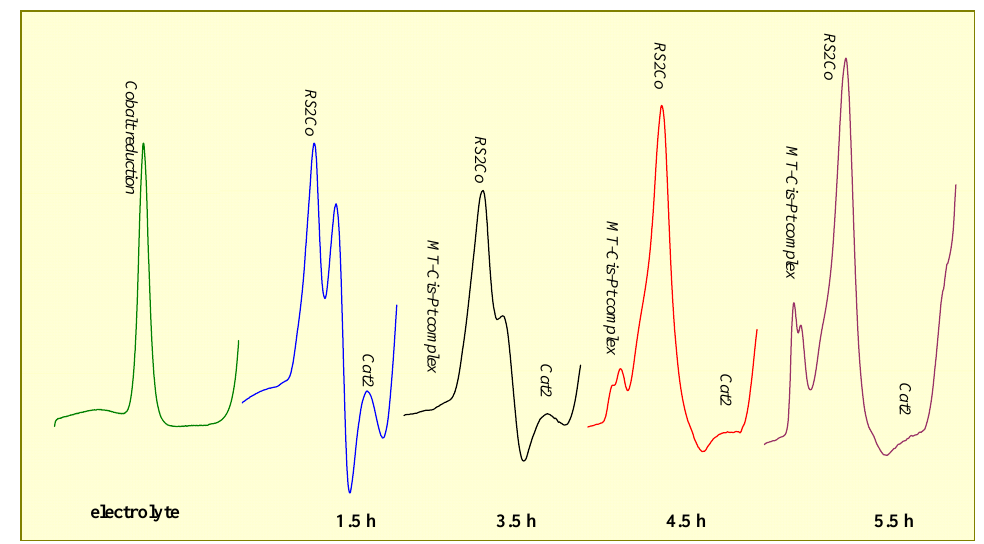
Figure 4. DP voltammograms of the rats´ blood treated with cisplatin for certain time